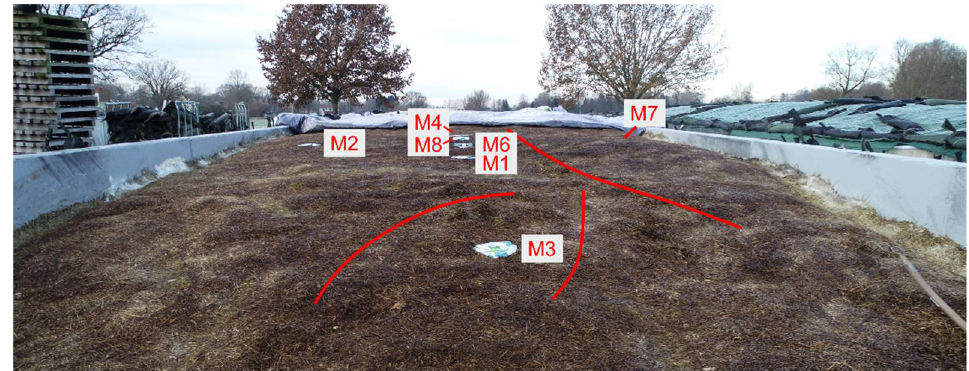
Figure 12. Topography of the full-scale silage test with grass. The surface is not even. It is conceivable that gas flow underneath silage film therefore is influenced by these circumstances.